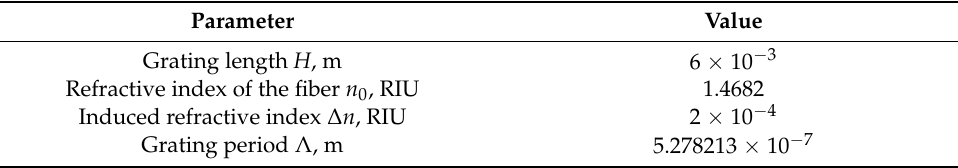
Table 1. Modeling parameters of the homogeneous non-apodized